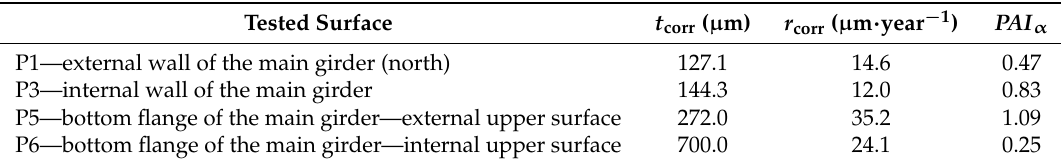
Table 6. Comparison of the average thicknesses of the corrosion layer t corr measured on the surface of the structure, corrosion rates r corr and PAI α